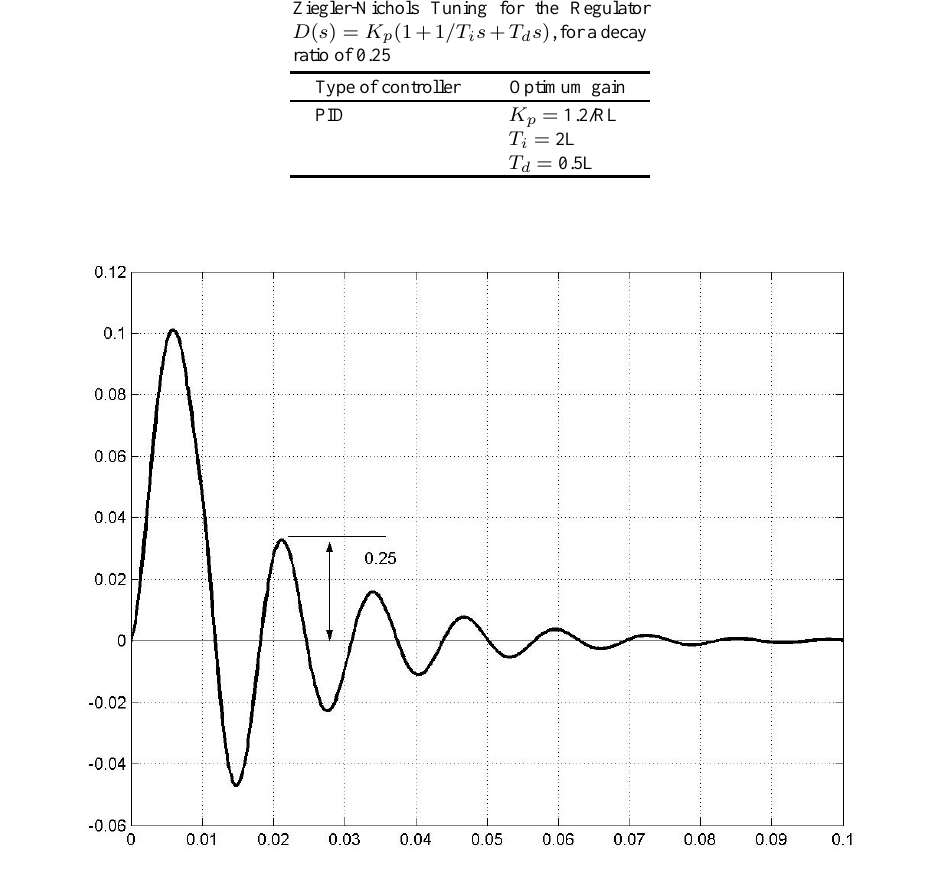
Fig. 14. The response of the system based on the quarter decay